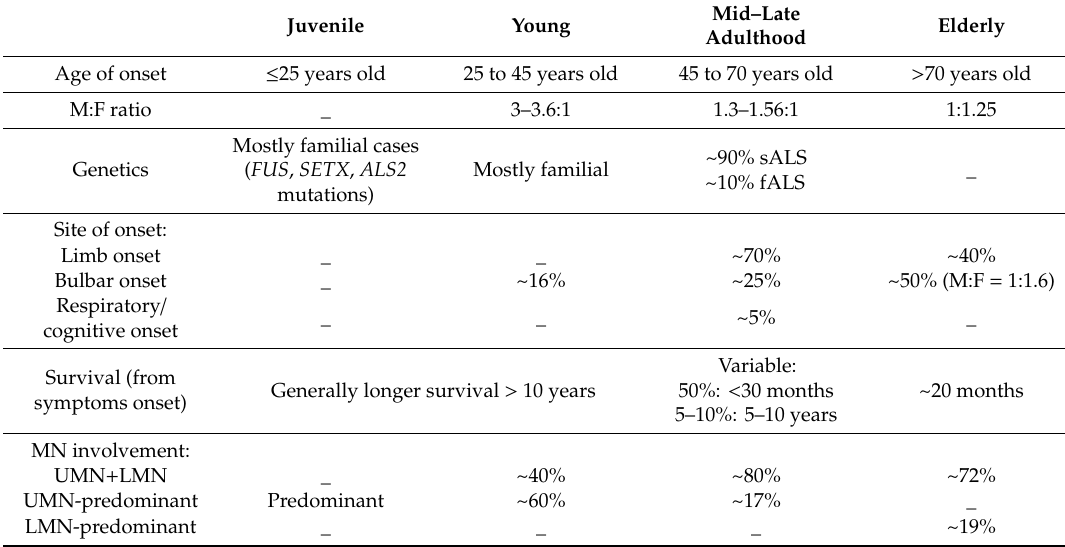
Table 1. ALS age of onset variability and their clinical features. Summary of clinical features for ALS in di ff erent age periods from Chio et al. [28], Forbes et al. [12], Swinnen et al. [27], Turner at al [26], Sabetelli et al. [29], and Kiernan et al. [25]. In addition to the classical ALS phenotype with age of onset ranging from 45 to 70 years old (mean age ~ 61 years old), three additional age of onset periods (columns) have been observed. Male to female ratios, genetic characteristics, site of onset, estimated survival time, and clinical features are shown where applicable. sALS: sporadic ALS. fALS: